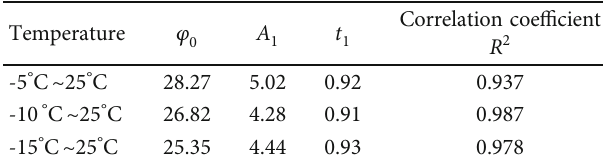
Table 3: Fitting parameters of freeze-thaw cycles and internal friction